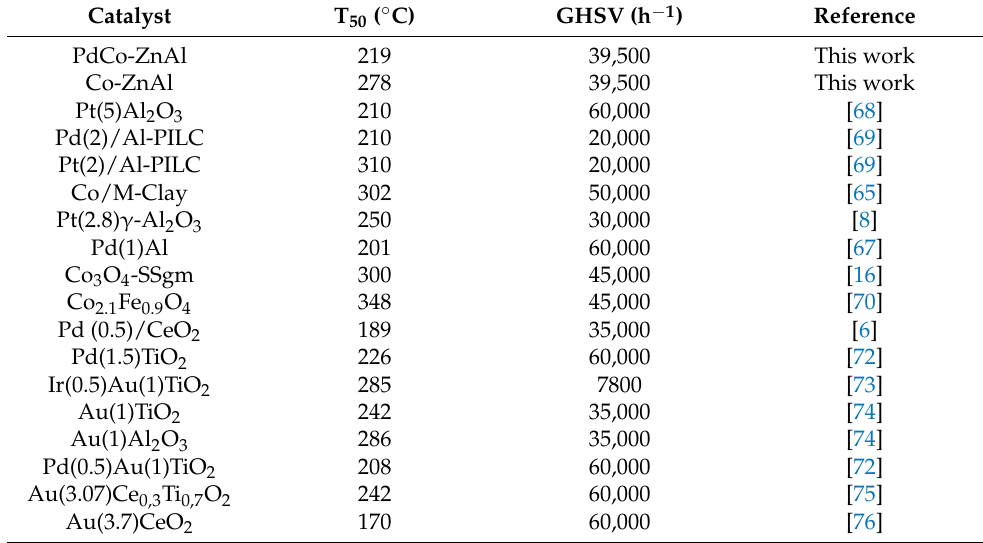
Table 5. Comparison of deep propene oxidation activity for different